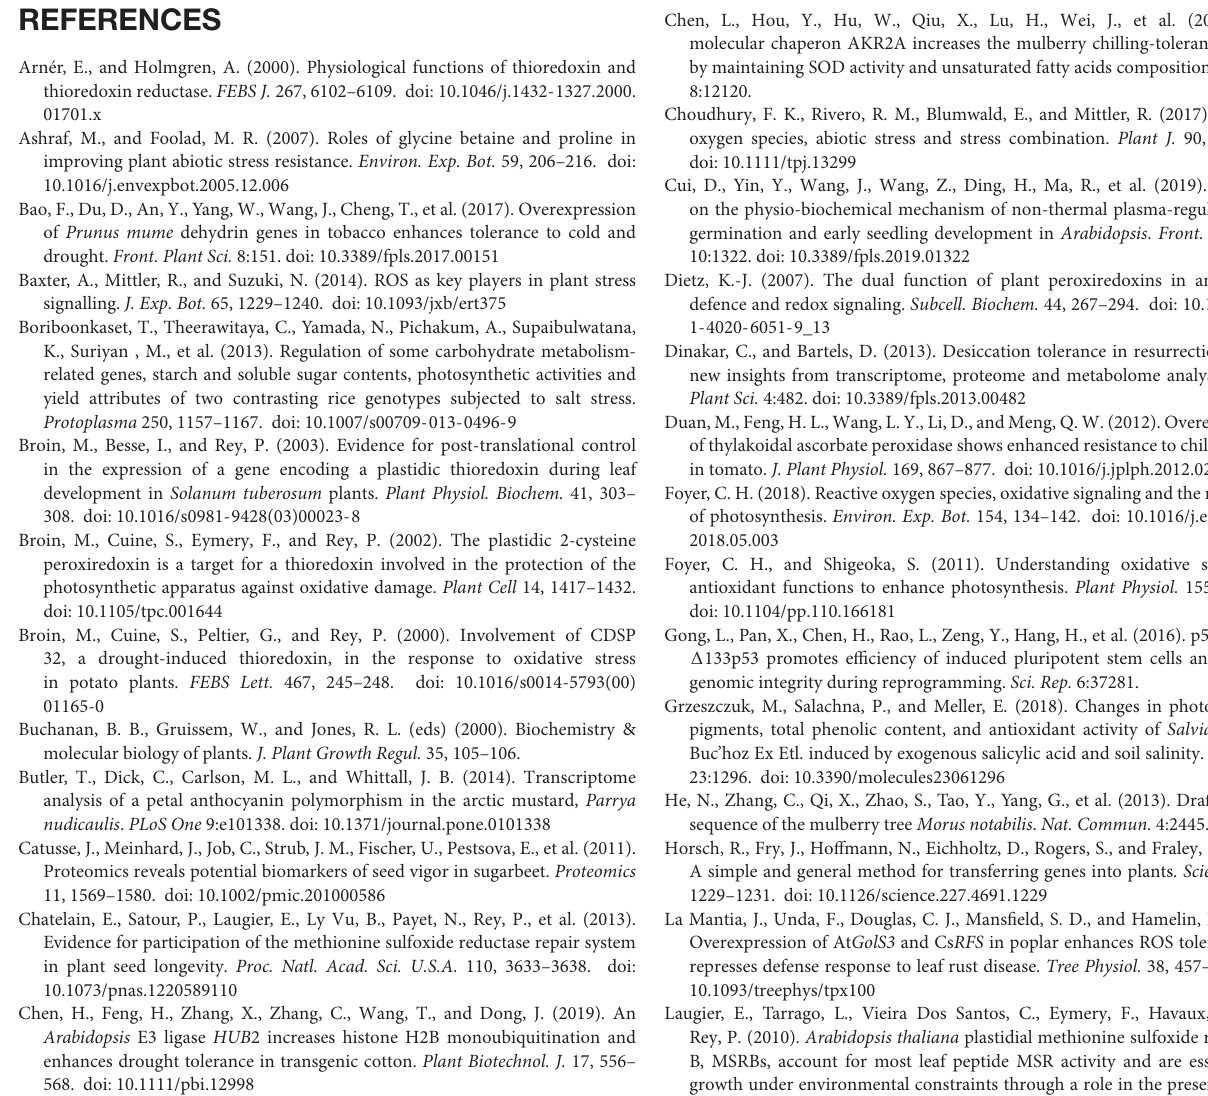
biological replicates were included. Asterisks indicate significant differences between the transgenic and WT lines ( t -test, ∗ P < 0.05, ∗∗∗ P < 0.001). FIGURE S2 | Gas exchange parameters in transgenic tobacco under abiotic stress. (A) Net photosynthetic rate ( Pn ). (B) Stomatal conductance. (C) Intercellular CO 2 concentration. (D) Leaf temperature. (E) Transpiration rate. (F) Phenotypes of 3-month-old WT and transgenic (OE-2 and OE-7) tobacco lines treated with 10 µ M methyl viologen (MV) for 25 h. The following treatments were used: 10 days of soil drought, 13 days of treatment with 200 mM NaCl and 25 h of treatment with 10 µ M MV. At least three biological replicates were included. Asterisks indicate significant differences between the transgenic and WT lines ( t -test, ∗ P < 0.05, ∗∗ P < 0.01 and ∗∗∗ P < 0.001). FIGURE S3 | Overexpression of MaCDSP32 helps maintain chloroplast pigment levels in transgenic tobacco under NaCl stress. (A) Total chlorophyll content. (B) Chlorophyll a content. (C) Chlorophyll b content. (D) Carotenoids content. Three-month-old WT and transgenic (OE-2 and OE-7) tobacco lines were treated with 200 mM NaCl for 13 days. At least three biological replicates were included. Asterisks indicate significant differences between the transgenic and WT lines ( t -test, ∗∗ P <